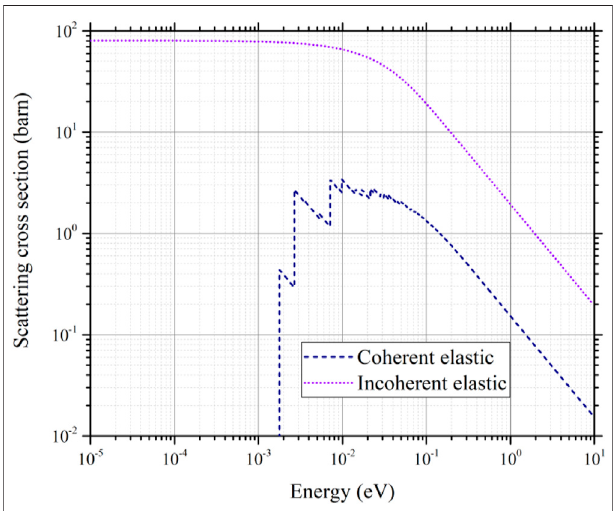
FIGURE 3 | Elastic scattering cross sections of δ -ZrH 1.5 .